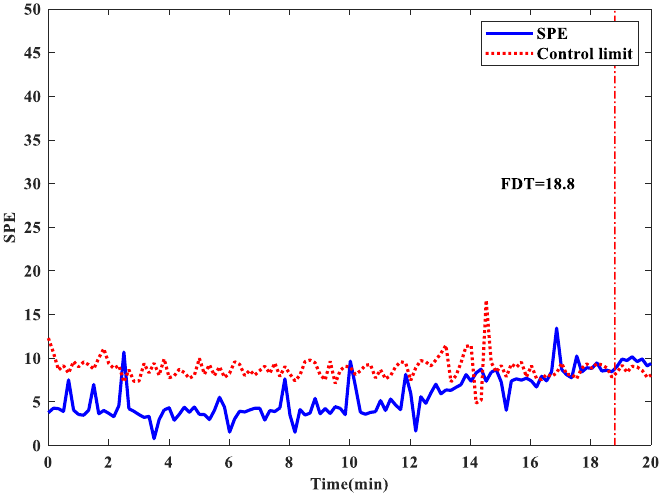
Figure 10. SPE fault monitoring chart of F5 based on MI-MPCA.